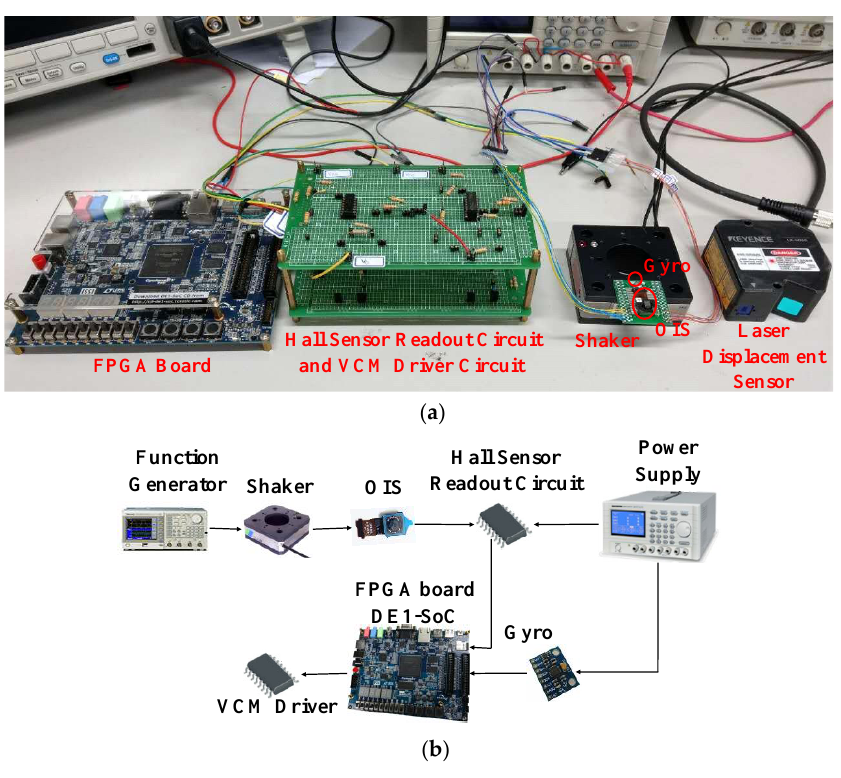
Figure 9. ( a ) Experimental Setup; ( b ) Devices and apparatus in connection.